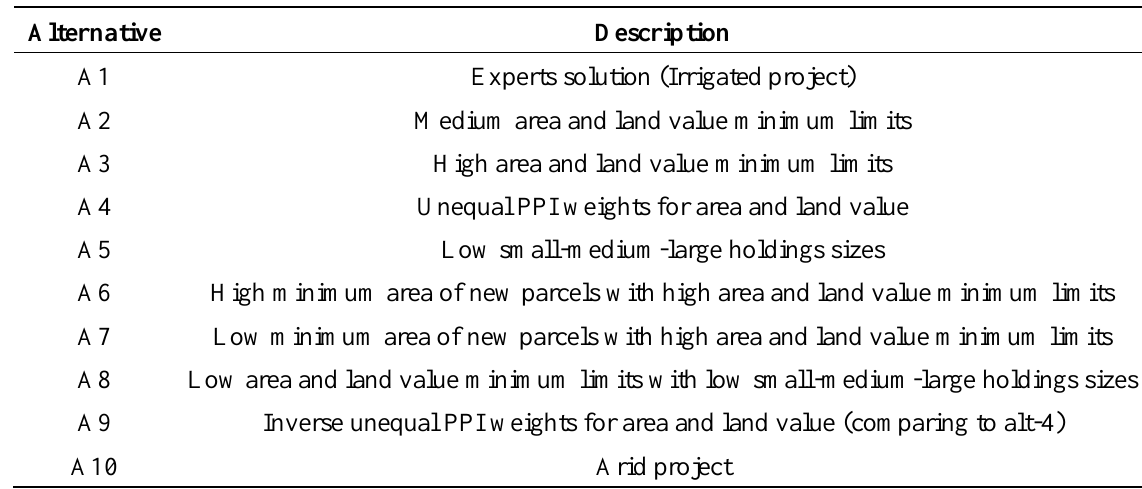
Table 3. The description of the ten alternative land